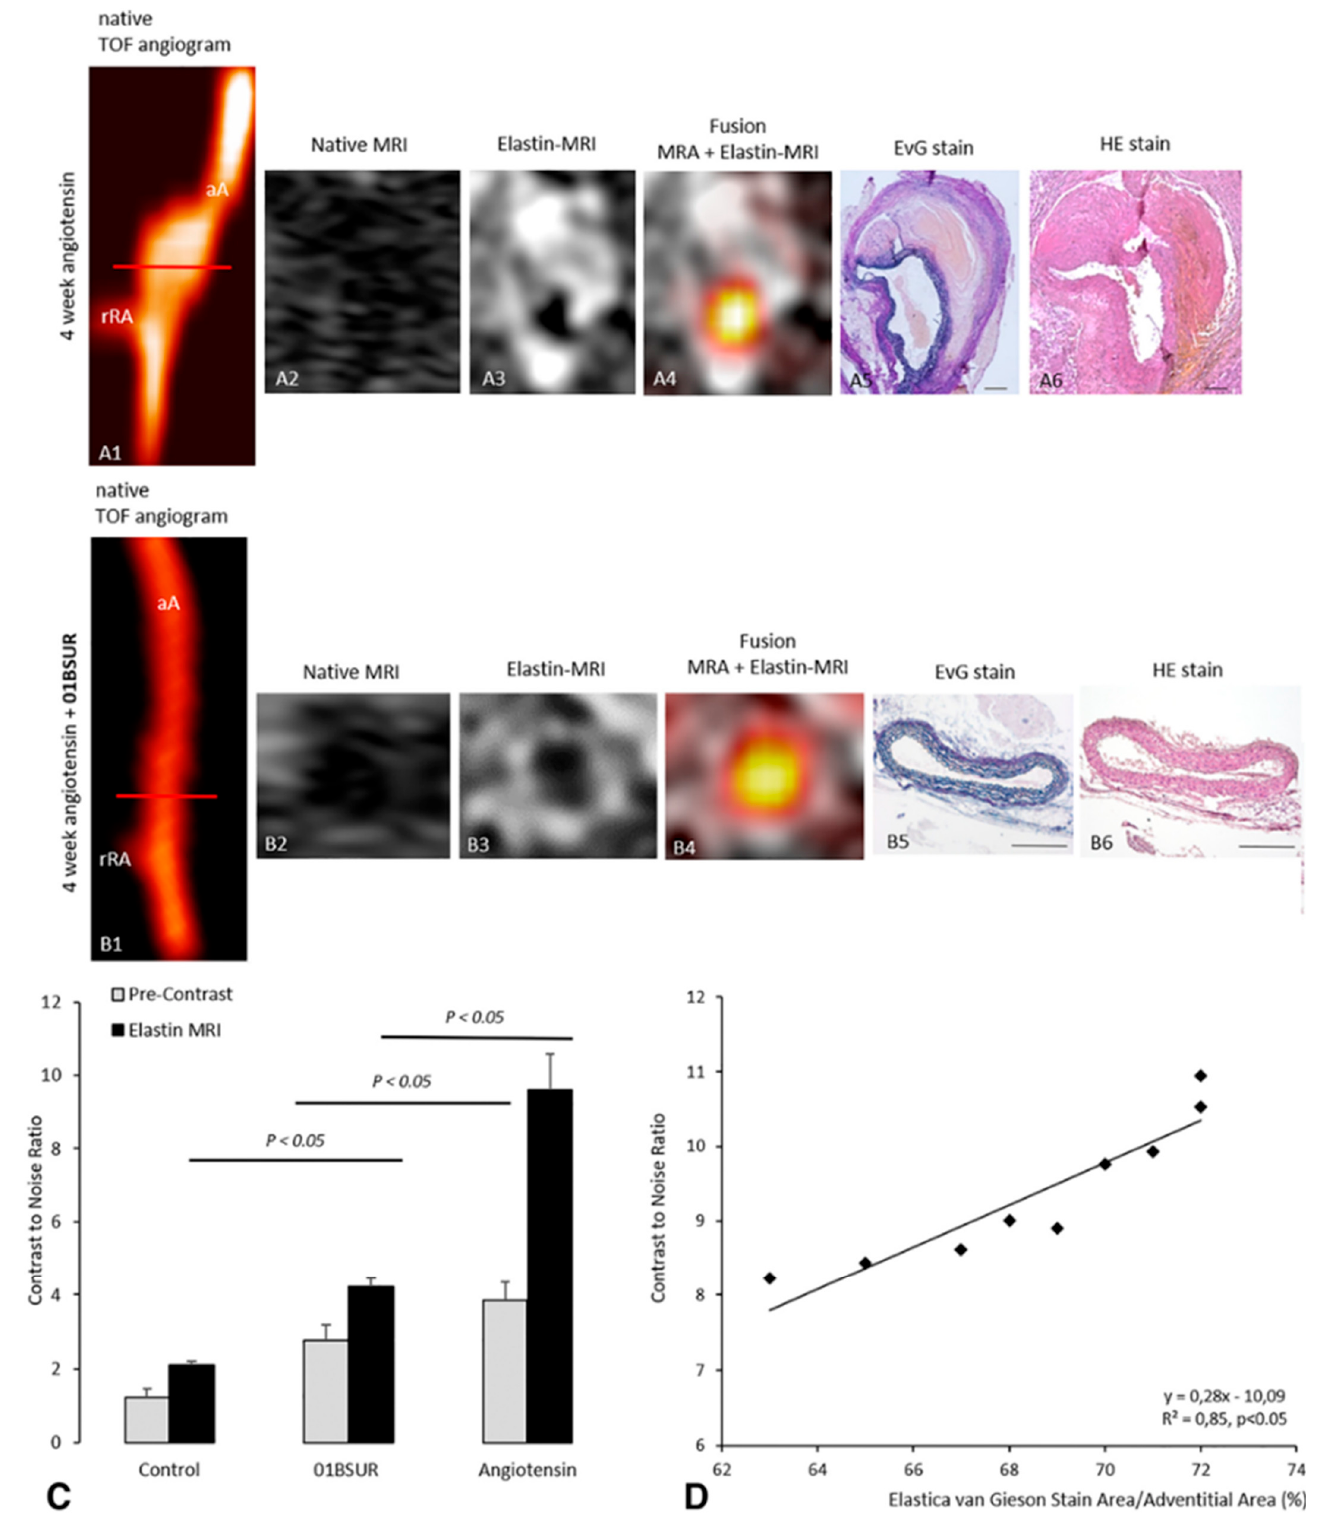
Figure 5. ( A1 – A4 ) and ( B1 – B4 ), in vivo molecular MRI of ECM of the aortic wall. 3D time-of-flight angiograms of the suprarenal abdominal aorta including the right renal-artery of a male ApoE-/- mouse after 4 weeks of Ang-II infusion ( A1 ). After 4 weeks of Ang II infusion, an AAA with strong signs of ECM remodeling developed, which was observed in vivo by MRI after administration of the elastin-specific probe ( A3 , A4 ) and ex vivo by histological analysis ( A5 , A6 ). The abdominal aorta of a male ApoE-/- mouse treated with the anti-murine IL-1 β -antibody 01BSUR shows no pathological changes of the aortic wall in vivo TOF angiogram ( B1 ), native MRI ( B2 ) and T1-weighted sequences using the elastin-specific probe ( B2 , B3 )